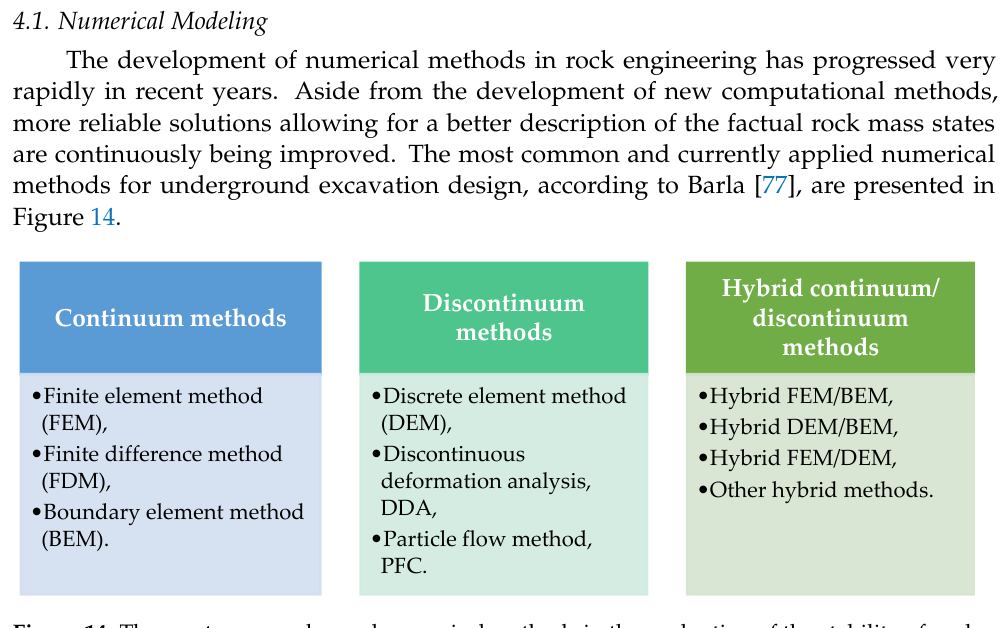
Figure 14. The most commonly used numerical methods in the evaluation of the stability of under- ground workings.